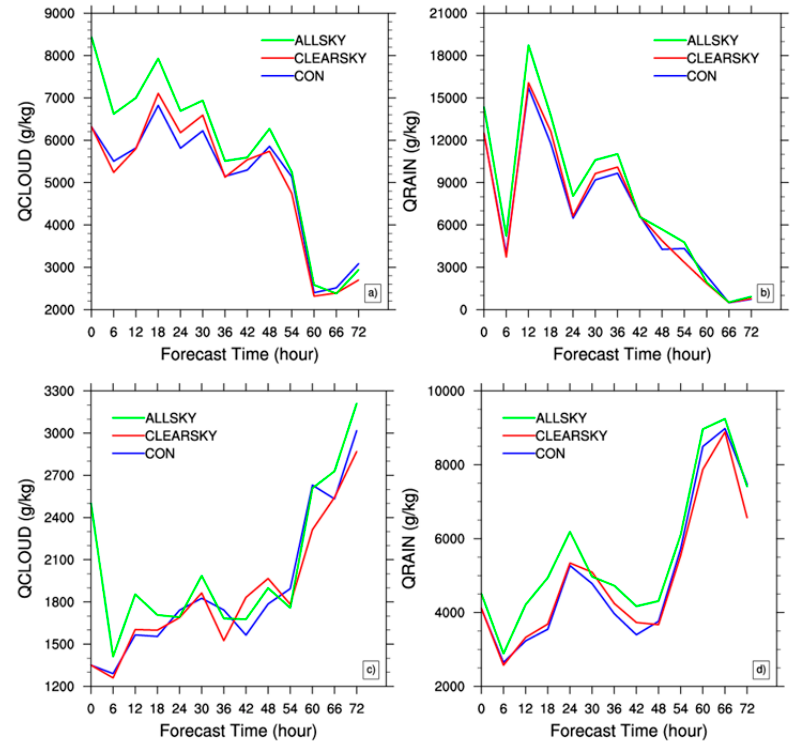
Figure 17. 72-h time evolution of integrated ( a , c ) cloud water mixing ratio (g / kg) and ( b , d ) rainwater mixing ratio (g / kg) for ( a , b ) Chan-hom and ( c , d ) Nangka.